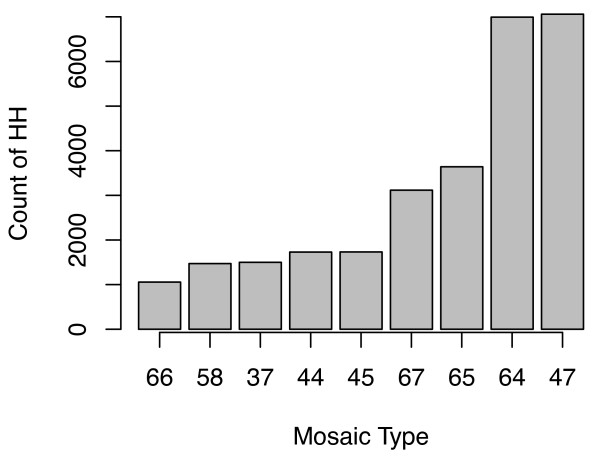
Mosaic type within "very high" risk LSOA. Filterered to only include HH counts > 1000.